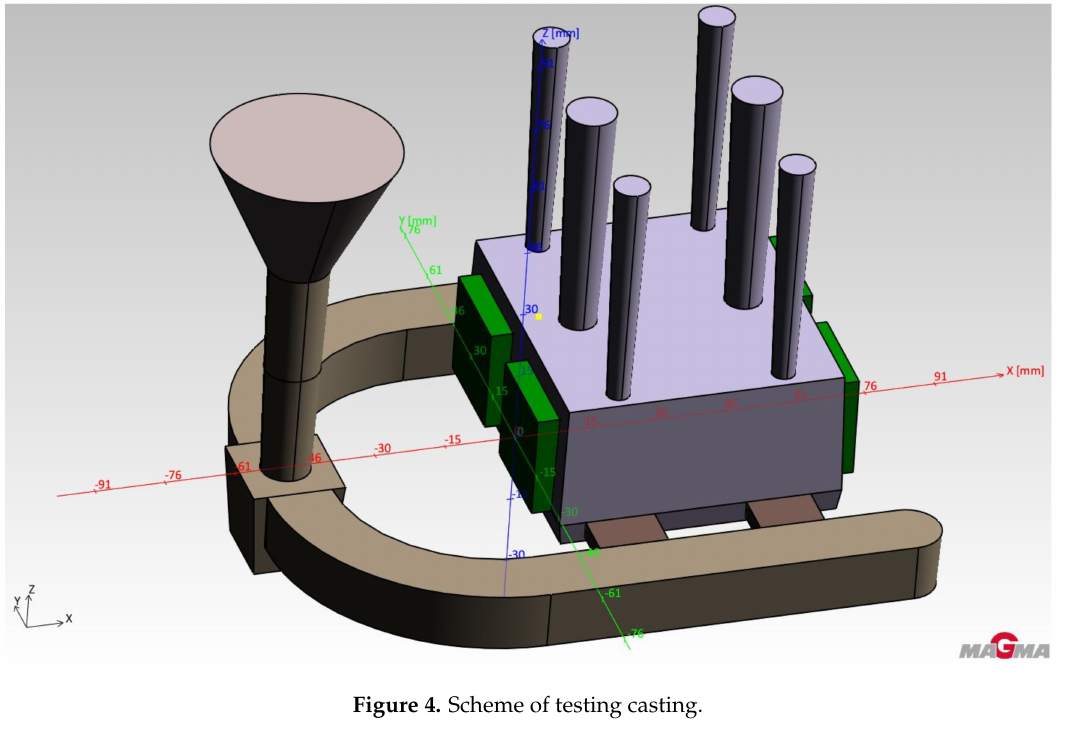
Figure 4. Scheme of testing casting.